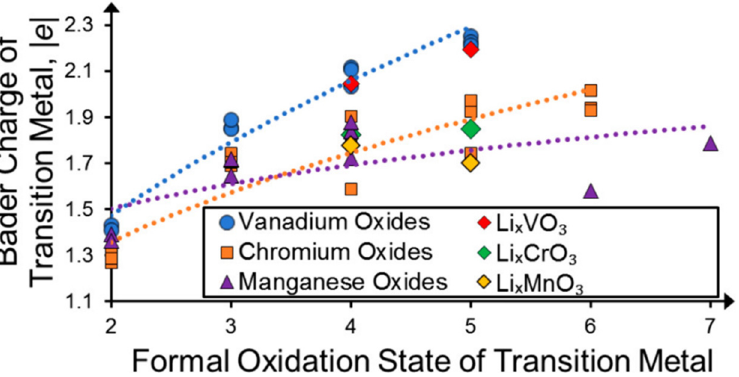
Figure 11. Bader charges of vanadium (blue circles), chromium (orange squares), and manganese (purple triangles) in different binary oxides as well as in their respective Li-excess materials (red, green, and yellow diamonds, respectively) versus the TM FOS. The dotted lines denote least-squares fitted power functions for a clearer distinction of the trends for each TM. Reprinted with permission from Ref. [24]. Copyright 2020 American Chemical Society.